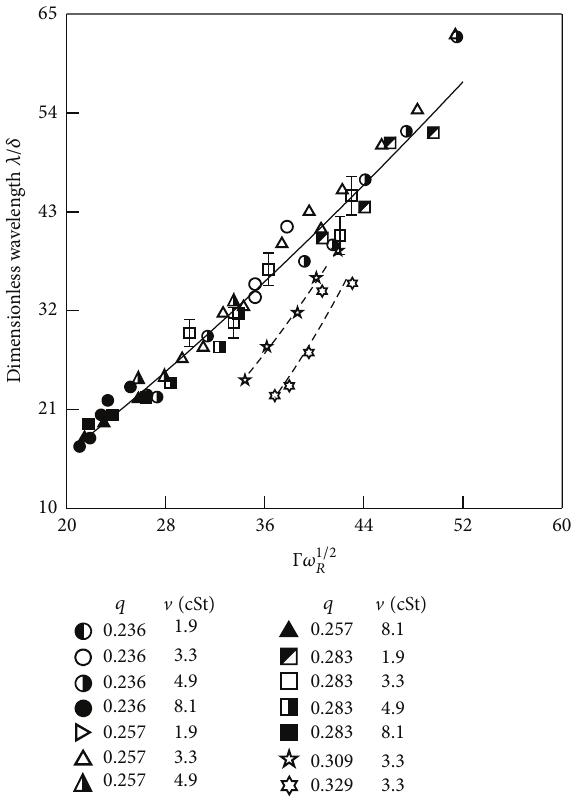
Figure 10: Dimensionless wavelength of regular ripples versus dimensionless parameter Γ𝜔 𝑅1/2 ; solid line corresponds to 𝜆/𝛿 ∼ (Γ𝜔 𝑅1/2 ) 4/3 , 𝑚 = 250 g. The experimental data are obtained unless 𝑇 < 10 3